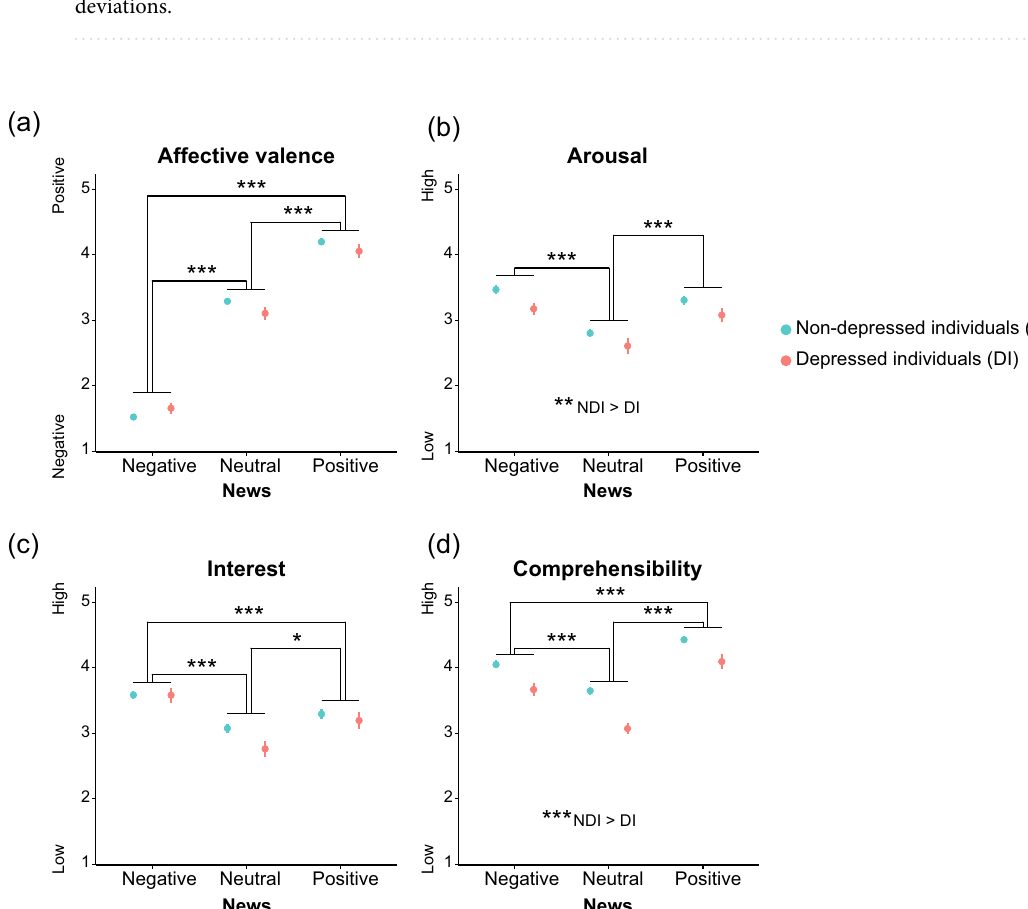
Table 2. Characteristics of news selected based on the preliminary survey (N = 160). Mean ± the standard deviations.